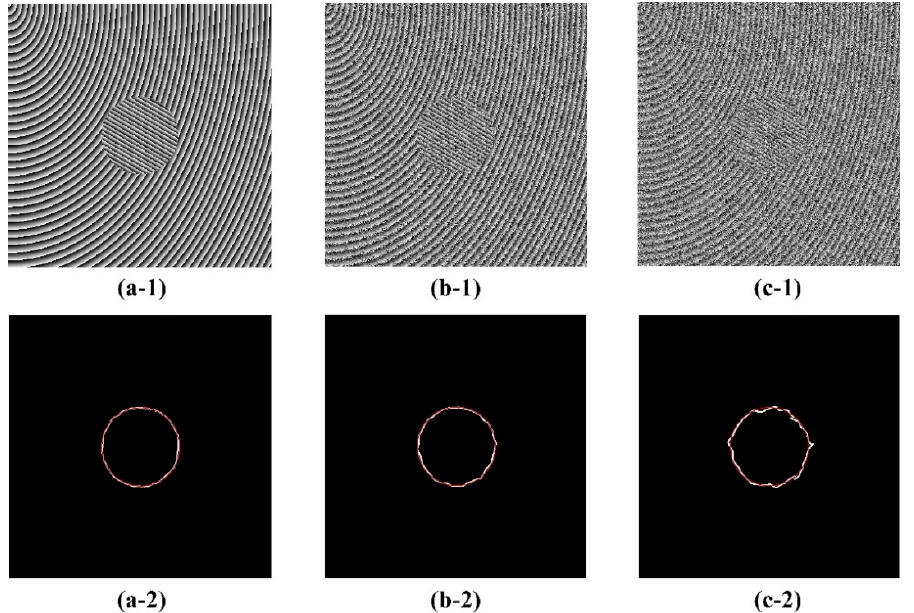
Figure 4. Simulated fringe patterns (CIRCLE): ( a - 1 ) noiseless, ( b - 1 ) random noise (variance 0.8), ( c - 1 ) random noise (variance 1.5). Weight mask’s segmentation results: ( a - 2 ) noiseless, ( b - 2 ) random noise (variance 0.8), ( c - 2 ) random noise (variance 1.5).